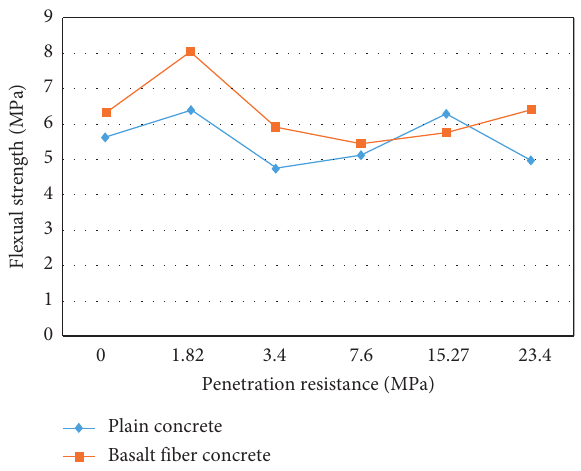
Figure 3: Comparison of flexural strength of plain concrete and basalt fiber